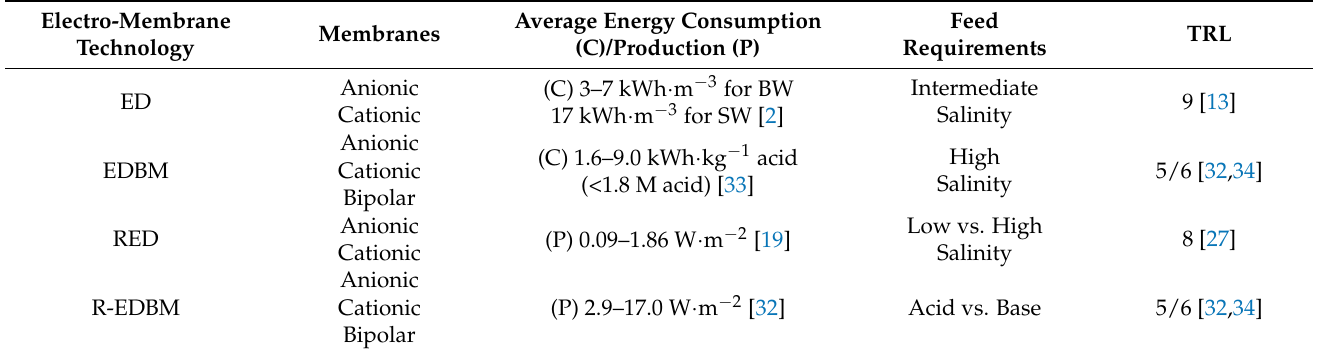
Table 2. Main elements and characteristics of electro-membrane technologies in the desalination industry.